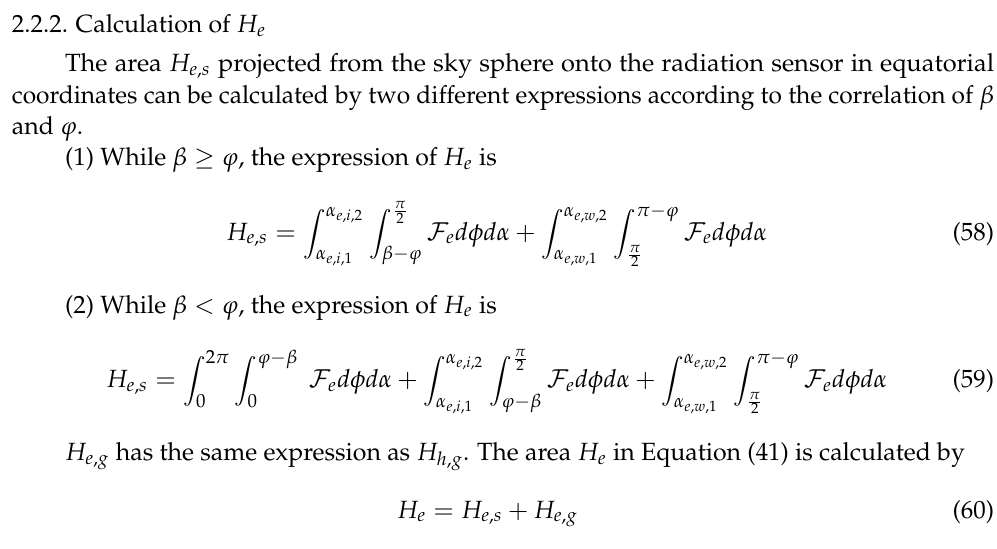
Figure 19. Schematic diagram for the calculation of S e while φ e , r ≤ π /2 and β ≤ φ e , l + ϕ . If the axis Y is between the points A and B, the second term of Equation (57) on the right-hand side is equal to zero and S ( 7 ) will not